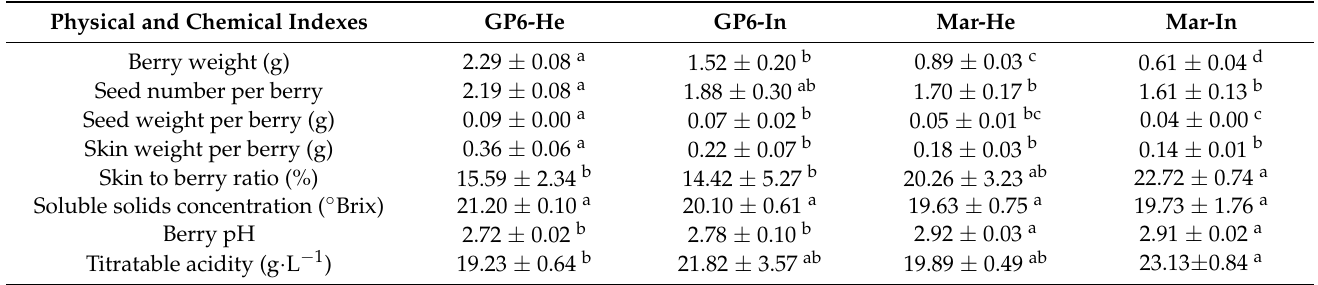
Table 1. Comparison of physical and chemical indexes between healthy berry and infected berry of two grape